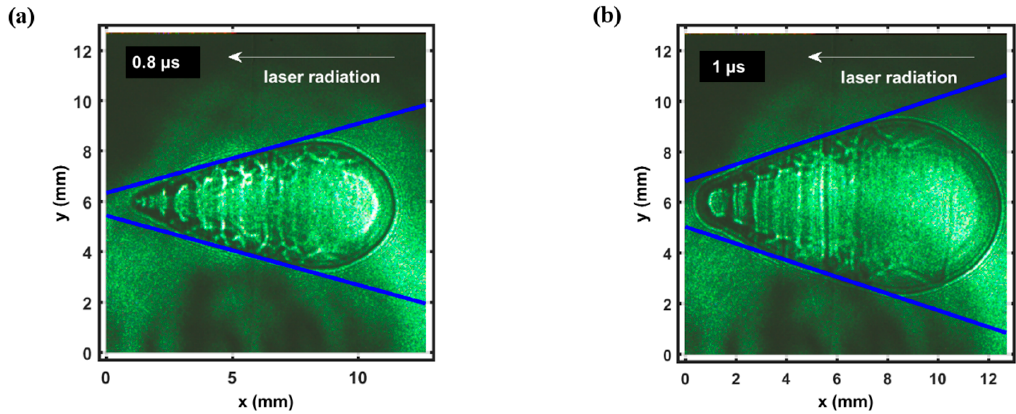
Figure 2. Shadowgraphs ( a ) 0.8 µs and ( b ) 1 µs. At 1 µs, the plasma expands vertically at ~Mach 3 (~1 km/s). The slopes in ( a ) and ( b ) are ±3.6 and ±3, respectively, indicate the forward shock-wave envelopes [26].